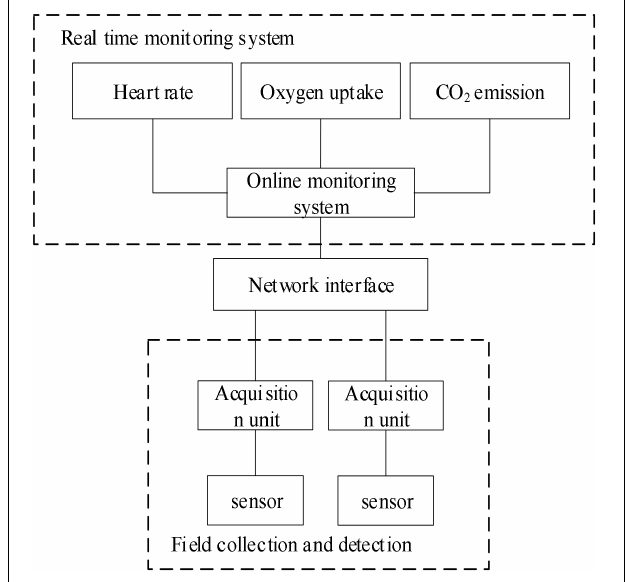
FIGURE 5 | Information fusion processing of sports on mental health status